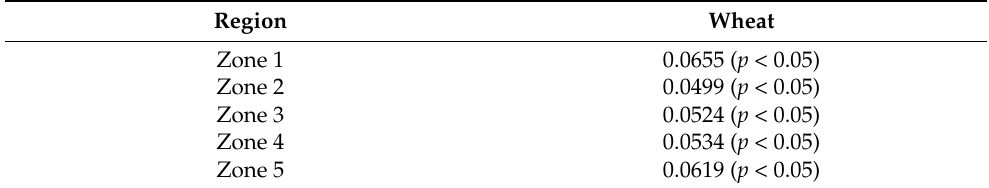
Table 3. Trend analysis of the yield for selected zones. Region Wheat Figure 4. Fractional frequency of the Standardized Precipitation Index (SPI) for the wheat crop in different zones of Punjab, ( a ) Zone 1, ( b ) Zone 2, ( c ) Zone 3, ( d ) Zone 4 and ( e ) Zone 5